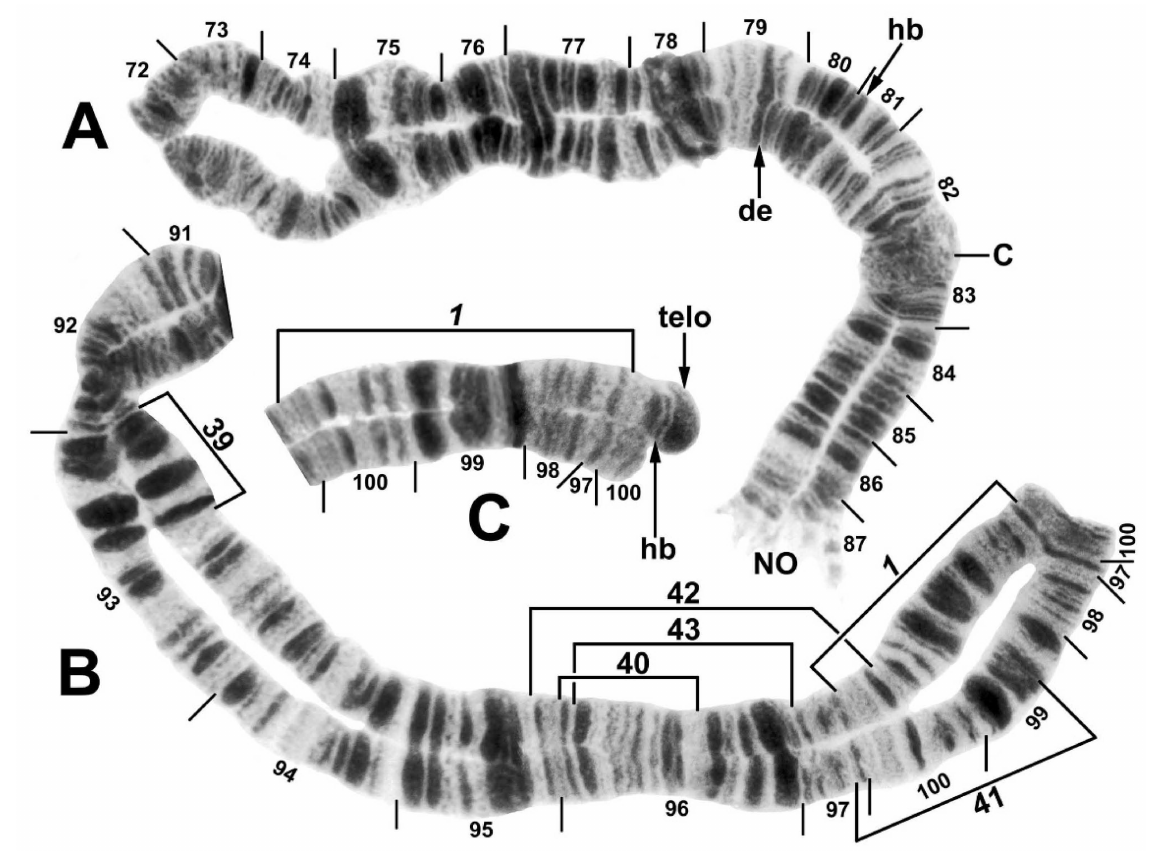
Figure 4. Chromosome III of the Simulium ornatum group from Kyrgyzstan. ( A ) IIIL base and IIIS heterozygous for a single band deletion (de), indicated with an arrow pointing to where the missing band should be (female larva, site 60). Location of a heteroband (hb, not shown) is indicated with an arrow; C, centromere; NO, primary nucleolar organizer. ( B ) IIIL (sections 91–100) showing the IIIL-1 sequence (female larva, site 34). Breakpoints of polymorphic inversions IIIL-39, IIIL-40, IIIL-41, IIIL-42, and IIIL-43 are indicated by brackets. ( C ) IIIL end showing the IIIL-1 sequence and heterozygous configuration for an amplified telomere (telo), as well as its associated subterminal band (hb) in section 100, both indicated with arrows (composite male larva, site